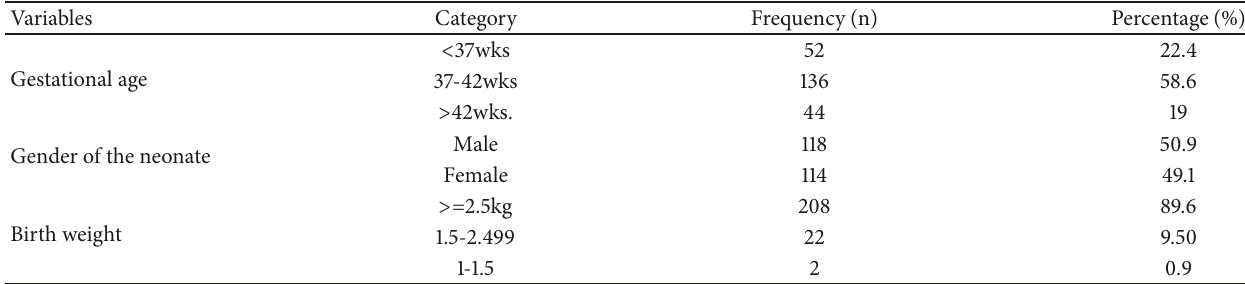
Table 2: Labor and delivery characteristicsof mothersdelivered at Dangla Primary Hospital, Awi Zone, AmharaRegion, Northwest Ethiopia, 2017 (n=232).